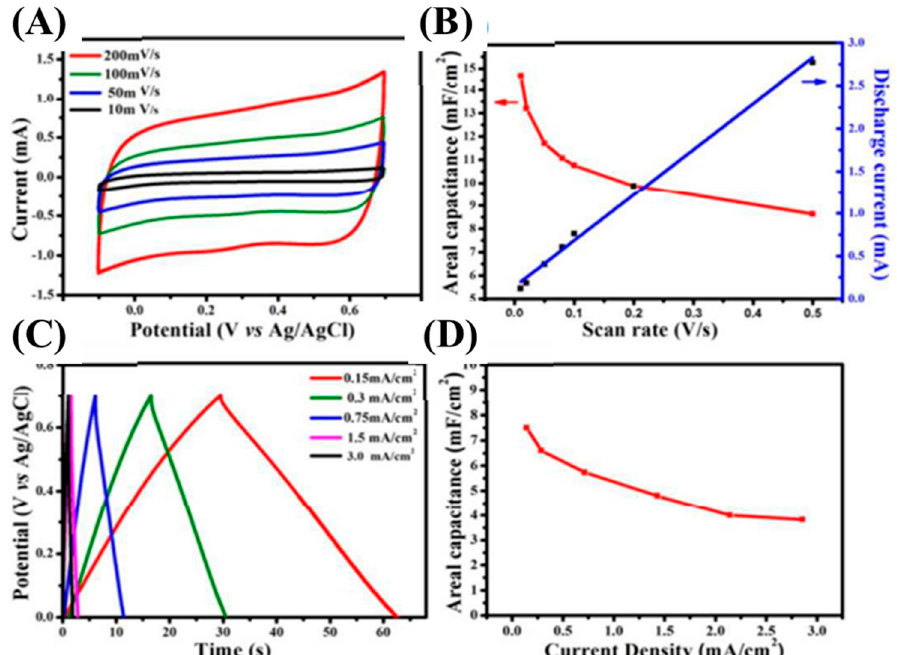
Figure 10. CV curves at various scan rates ( A ); relation between areal capacitances and discharge currents with different scan rates ( B ); GCD curves at different current densities ( C ); and relation between areal capacitances with different current densities ( D ) [106].